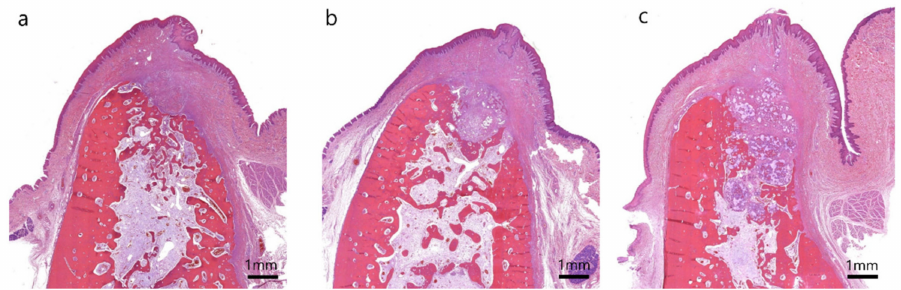
Figure 5. Buccolingual section on hematoxylin and eosin staining at 4 weeks after extraction in the ( a ) control group, ( b ) T1 group and ( c ) T2